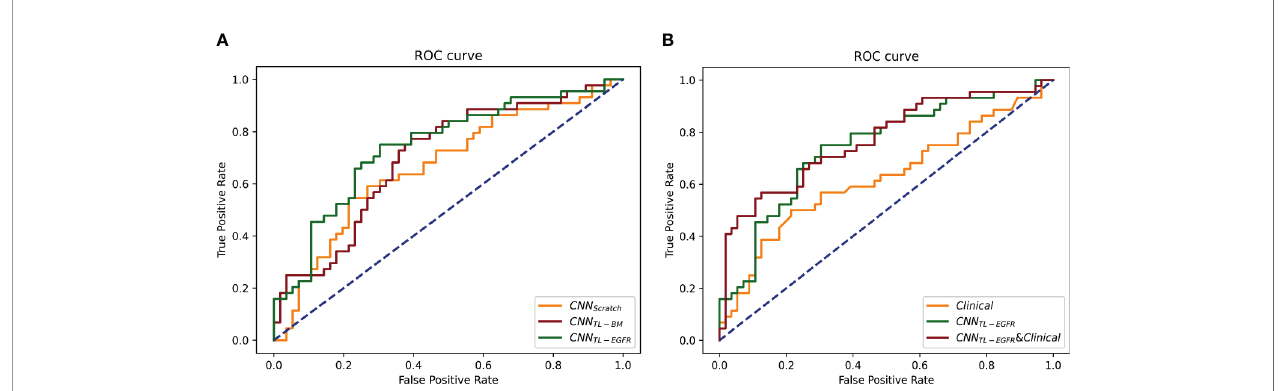
FIGURE 3 | ROCs of 3D CNN models for the prediction of PFS in the validation group. (A) The ROCs of 3D CNN model trained from scratch, using transfer learning based on nodule or EGFR classi fi cation models. The corresponding AUCs were 0.668, 0.701, and 0.744, receptively. (B) The ROCs of only using clinical features, 3D CNN (using transfer learning based on EGFR classi fi cation model), and the combination of 3D CNN and clinical features, and the corresponding AUCs were 0.624, 0.744, and 0.771.